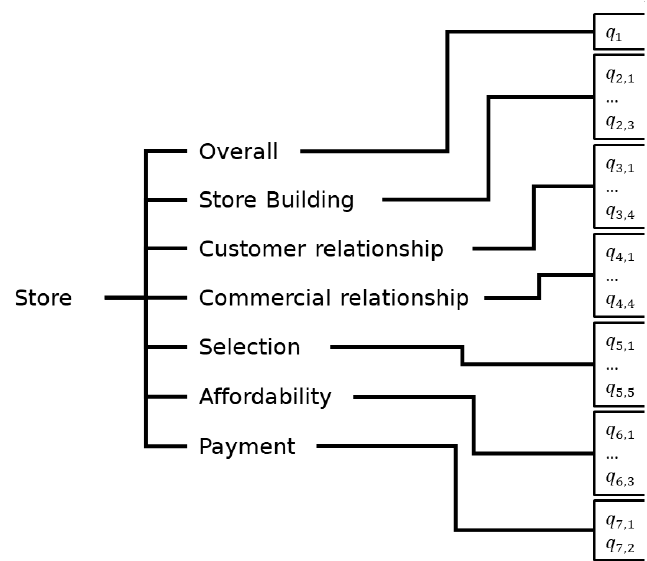
Figure 1. An example of the KPI tree related to the experience inside a store.